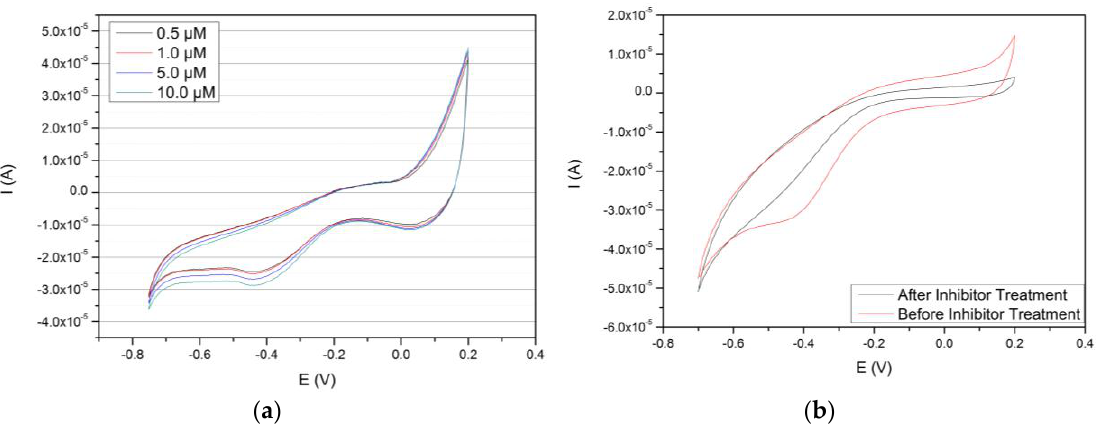
Figure 6. Cyclic voltammograms of the Au/MPS/PAMAM G4.0-Au/CYP3A4 electrode. ( a ) Shows the behaviour of the electrode with 0, 0.5, 1.0, 5.0 and 10.0 µM of caffeine, respectively. An increasing, reductive current can be observed at ~ −400 mV. ( b ) Depicts two voltammograms produced before and after treatment with CYP3A4 inhibitor eryhtromycin and under presence of substrate caffeine. An almost total disappearance of the typical P450-related reduction peak can be